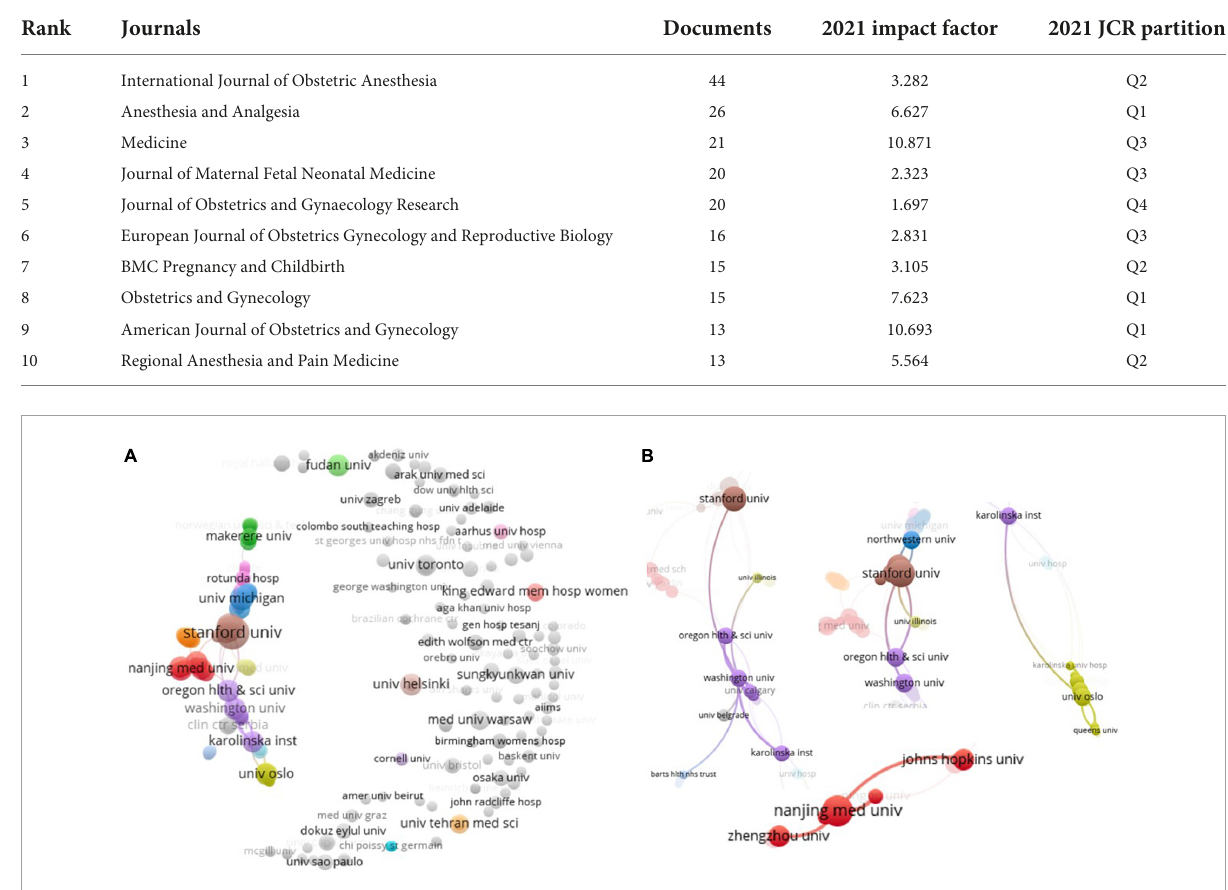
TABLE 3 Top 10 with the largest number of publications.